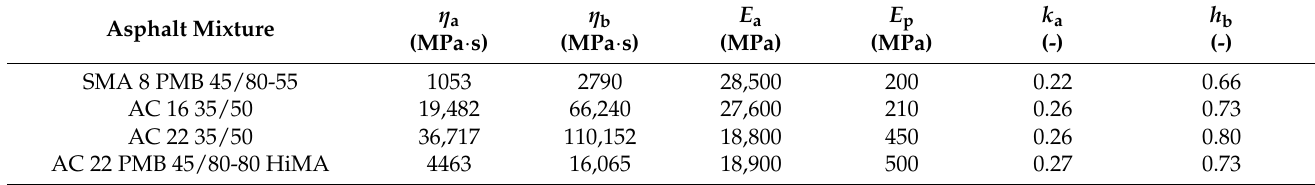
Table 2. Material parameters of asphalt mixtures for the Huet-Sayegh model of asphalt layers at T = 10 ◦ C. Asphalt Mixture